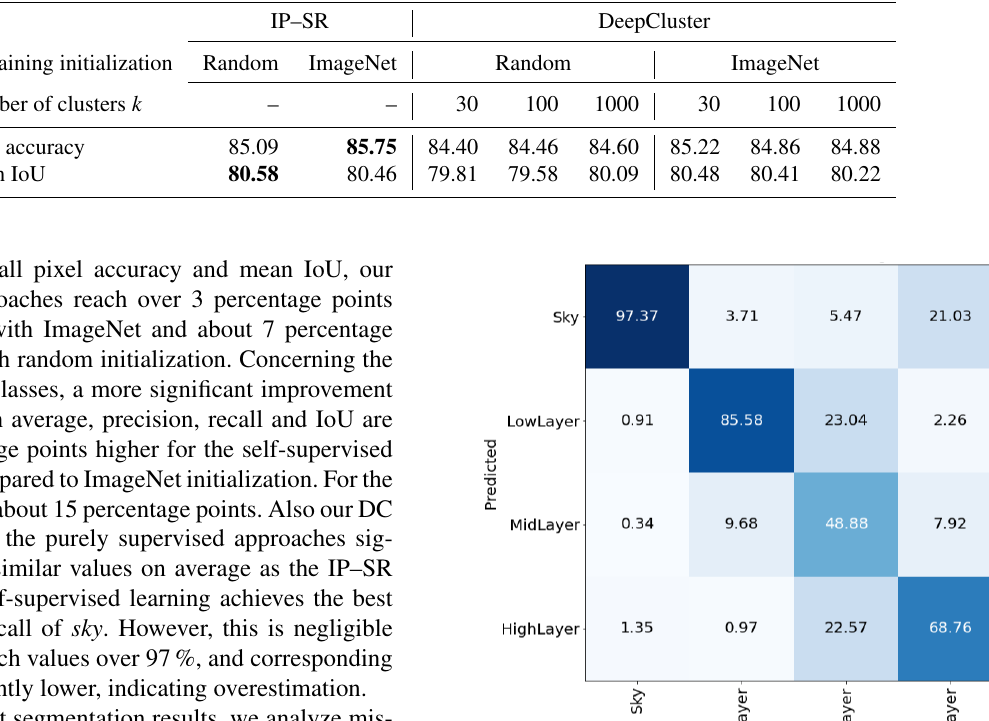
Table 2. Comparison of segmentation results when testing different training setups for self-supervised pretraining. Best values are highlighted in bold.